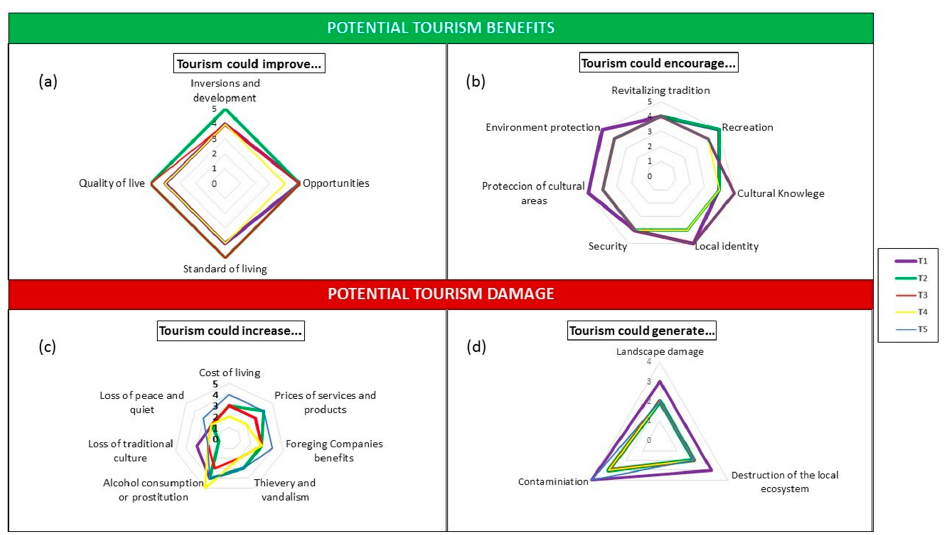
Figure 5. Radar charts representing the responses of the people surveyed to questions about the possible positive and negative effects that tourism could have on the territory. Subsections ( a – d ) group the questions according to the category to which they